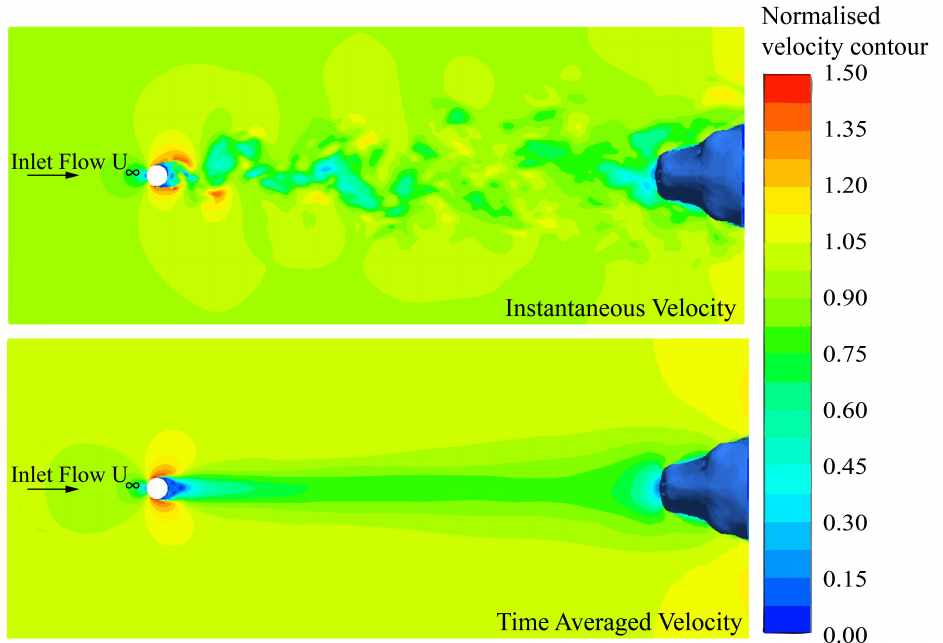
Figure 3. Velocity field through the test section from CFD Simulation (displayed as color-coded contours of constant streamwise velocity). Top: Instantaneous velocity field, Bottom: Time-averaged flow pattern.